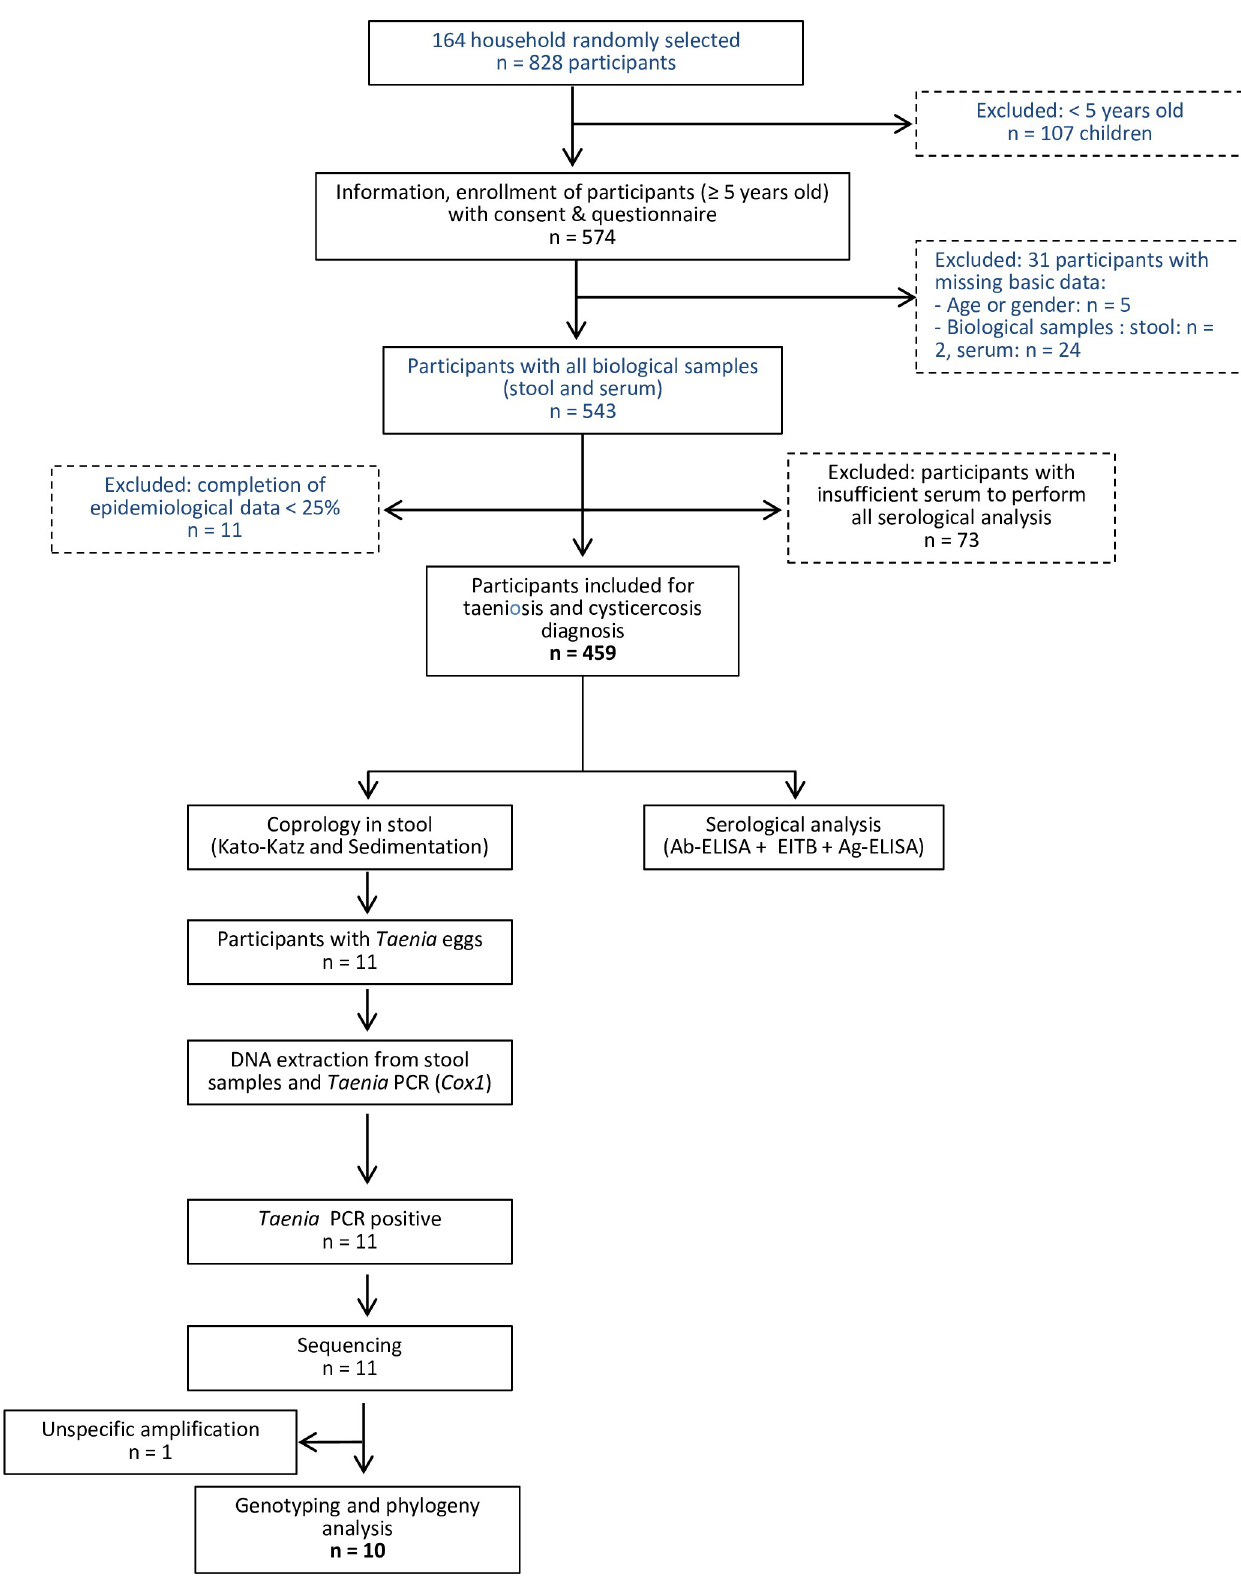
Fig 2. Flow diagram for taeniosis (coprology and molecular analysis) and cysticercosis (serological assays) performed during this study. https://doi.org/10.1371/journal.pntd.0010265.g002 PLOS NeglectedTropical Diseases | https://doi.org/10.1371/journal.pntd.0010265 April 11,